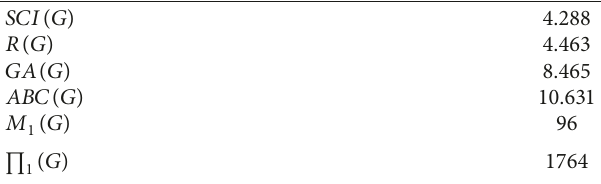
Table 1: Topological indices of G � B ( 5 ; 6 )